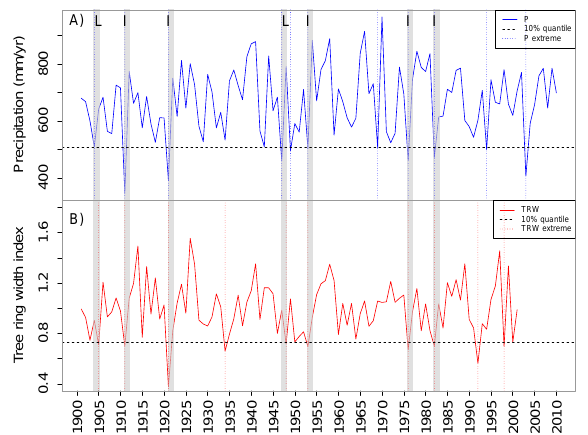
Figure 1. Example of coincidence analysis between a time series of (a) precipitation ( P ) and (b) tree ring width indices (TRW). The dashed horizontal line represents the lower 10% quantile. Events in precipitation or tree ring width that fall below this threshold are counted as extreme events, as indicated by the dotted vertical lines for P (blue) and TRW (red). Grey bars indicate the coinci- dence of extreme P and TRW events within a time window of 2 years ( (cid:49)t = 2) and are counted as one coincidence. In this exam- ple, we count 11 climate extremes and 7 coincidences with TRW for (cid:49)t = 2, resulting in a coincidence rate of r = 7/11 = 0.64. Note that if there are two TRW extremes coinciding with one P extreme in the time window of (cid:49)t = 2, this would account for only one ex- treme. The letters “I” and “L” indicate instantaneous and lagged effects (i.e. carry-over effects), respectively. When setting the time window to (cid:49)t = 1 and τ = 0, five coincidences are counted and for (cid:49)t = 1 and τ = 1, two coincidences are counted in this example.